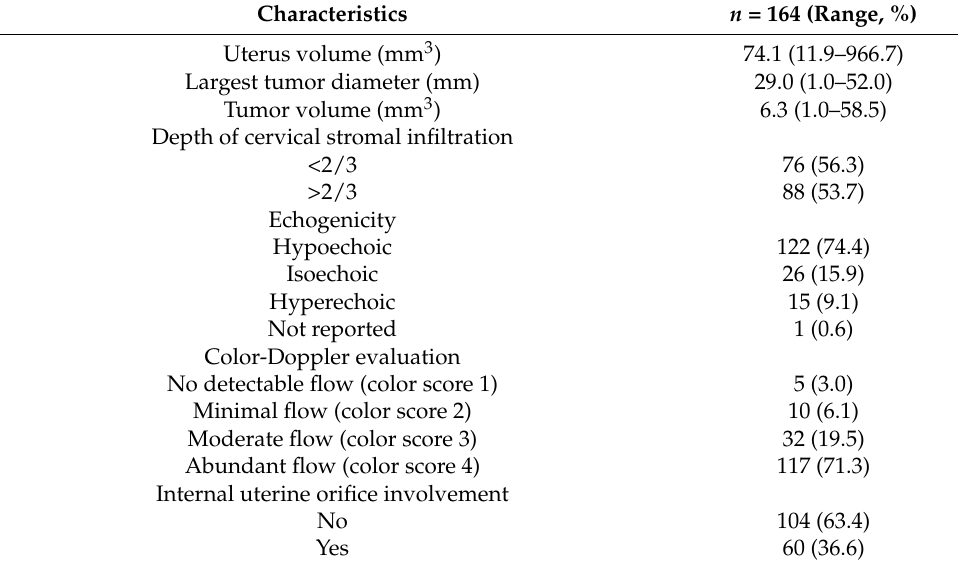
Table 2. Ultrasound characteristics of the study population.